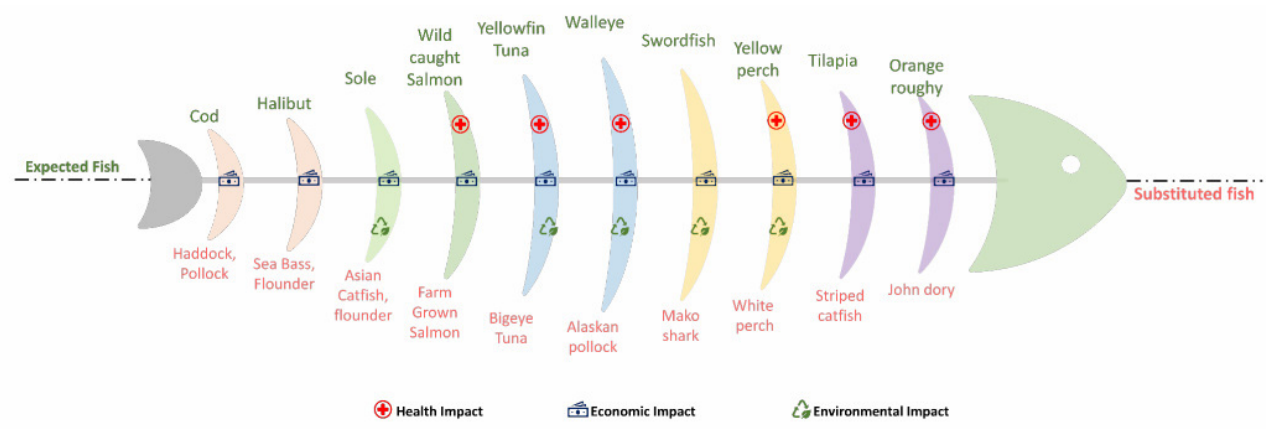
Figure 3. Commonly substituted fishes and their impacts